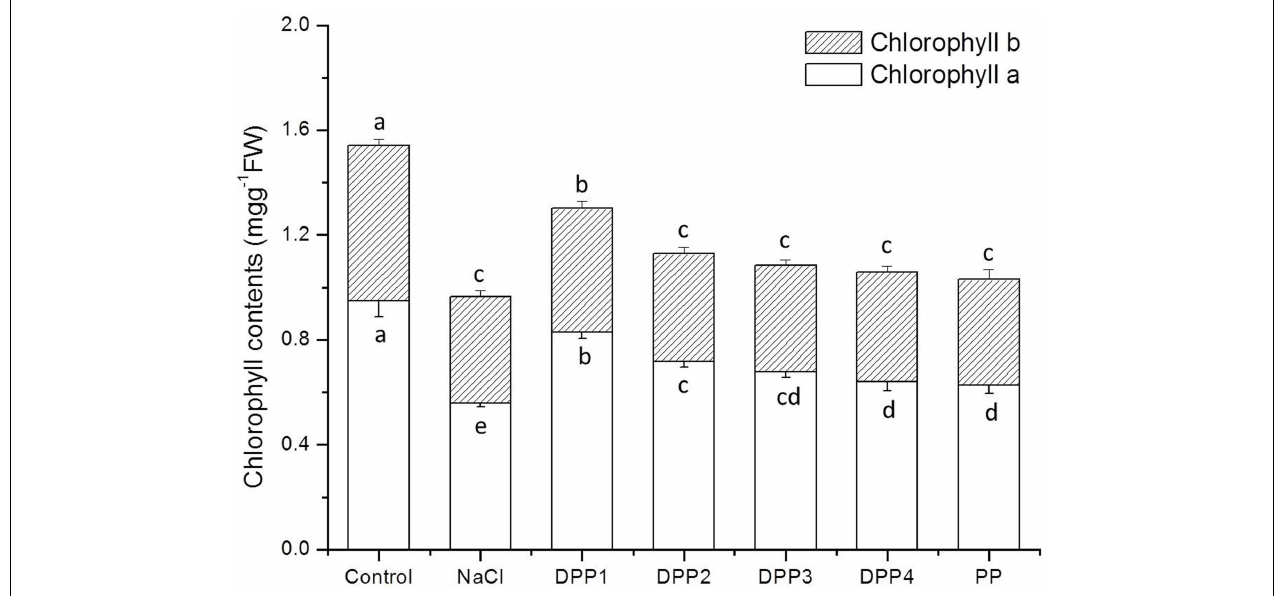
FIGURE 3 | Effect of four degraded (DPP1,2,3,4) and natural polysaccharides (PP) from P. yezoensis on chlorophyll content in wheat seedlings. Values are the mean ± SD of three replicates. Different letters indicate significant differences at P < 0.05.